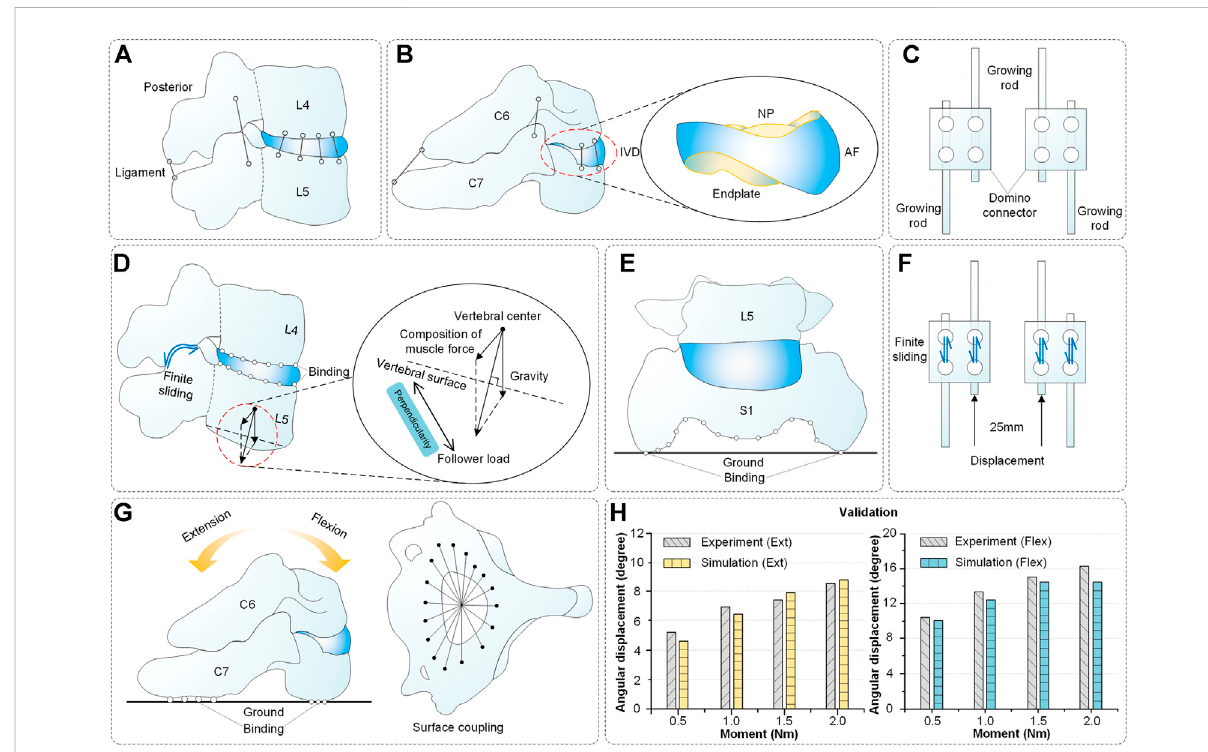
FIGURE 4 Spinal composition, constraint setting and validation. (A-B) Components of spinal reconstruction. (C) Structure of growing rods and domino connectors. (D) Spinal constraint setting (L4-L5 segments as an example) includes fi nite sliding (facet joints), binding (vertebra and IVD) and follower load (vertebrae). (E) Spinal constraint setting: binding (S1 segment and ground). (F) Constraint setting: fi nite sliding (growing rod and domino connector),displacementload(growingrod,0 – 25 mm). (G) Spinalconstraintsettingforvalidation.ThesuperiorsurfaceofC6wascoupledand applied a pure torque. The inferior surface of C7 was bound with the ground. (H) Validation results of the